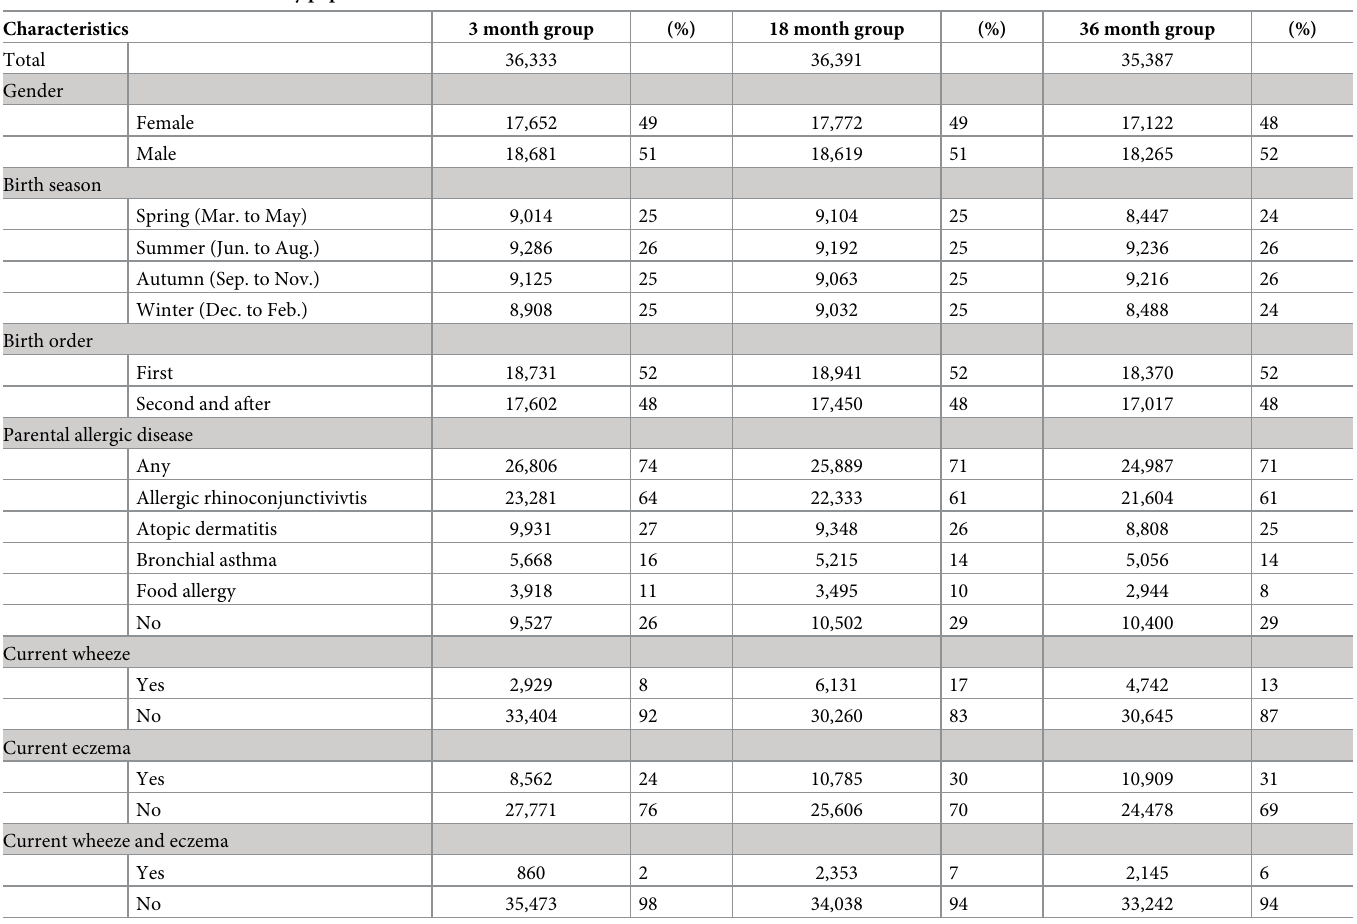
Table 1. Characteristics of the study